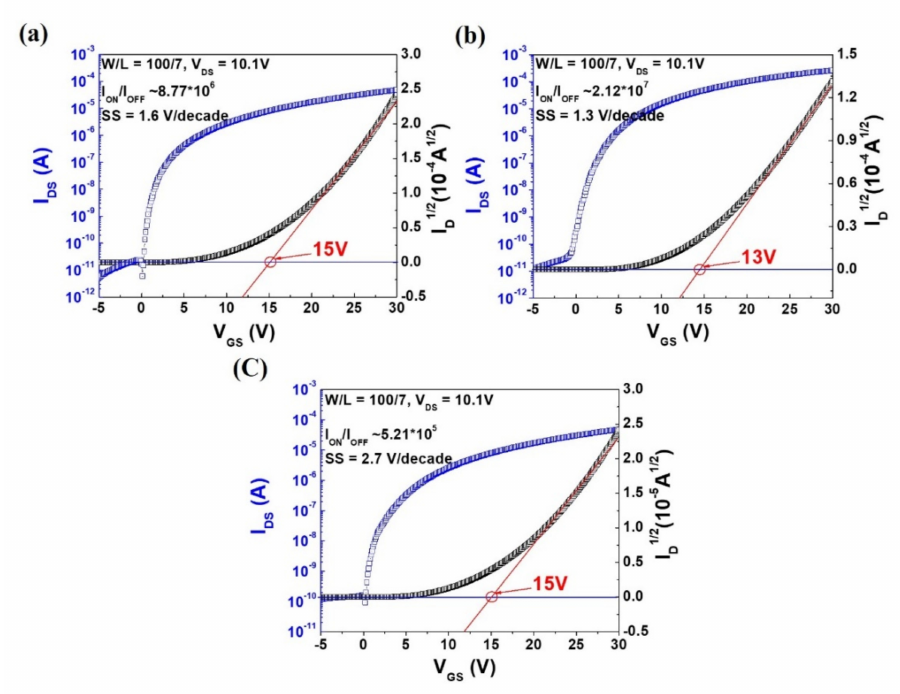
Figure 6. Transfer curves of the ( a ) Ta 2 O 5 (60 nm), ( b ) SiO 2 /Ta 2 O 5 (30 nm/30 nm), and ( c ) SiO 2 /a- IGZO TFTs. Heat treatment was carried out for 2 h in an oxygen atmosphere at 300 ◦